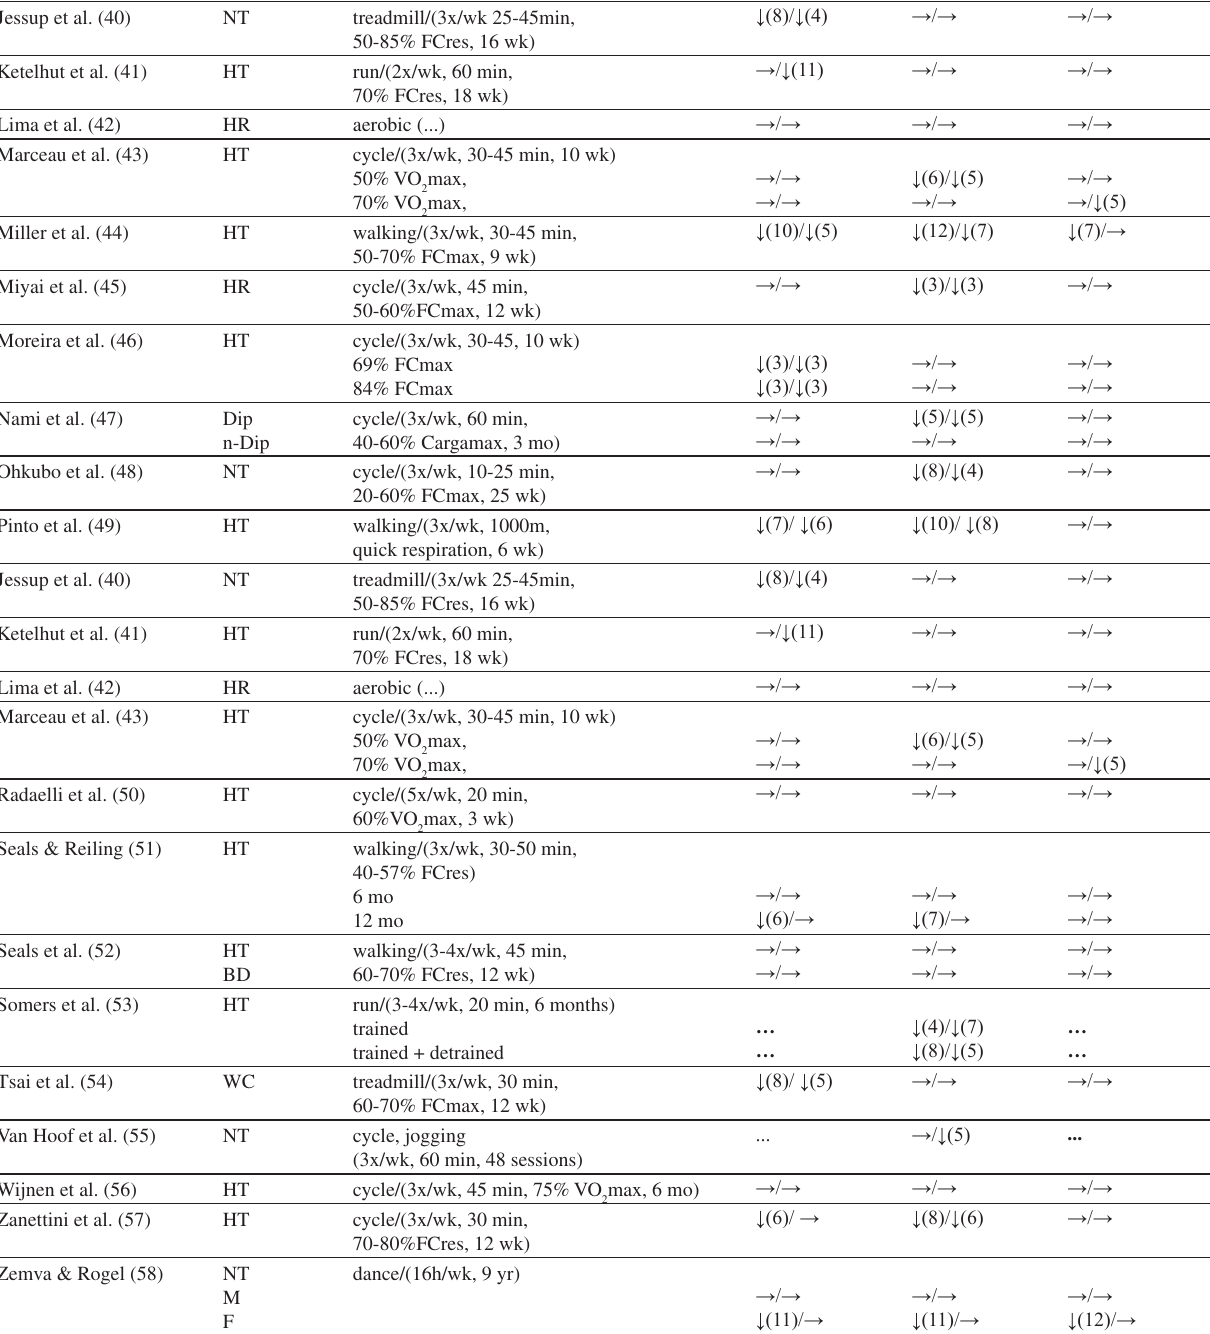
Table 2 - Effects of aerobic training on ambulatory blood pressure